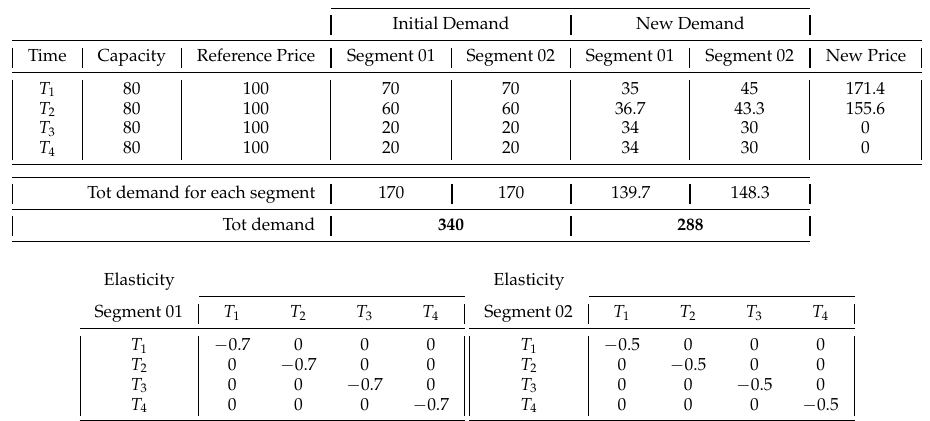
Table 10. Case Study 6.03—basic sub-case, data, and